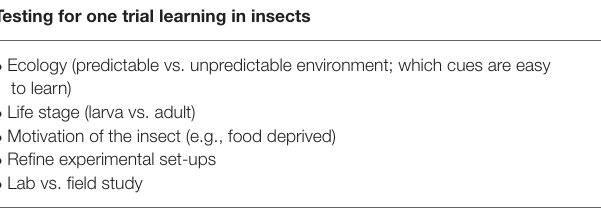
TABLE 1 | What to consider when testing insects for one trial learning. Testing for one trial learning in